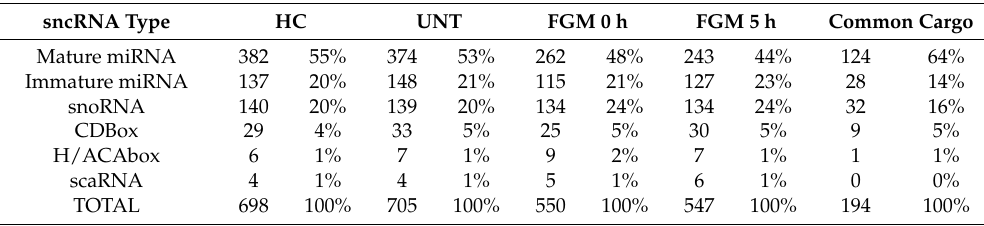
Table 2. sncRNA type distribution for each condition.